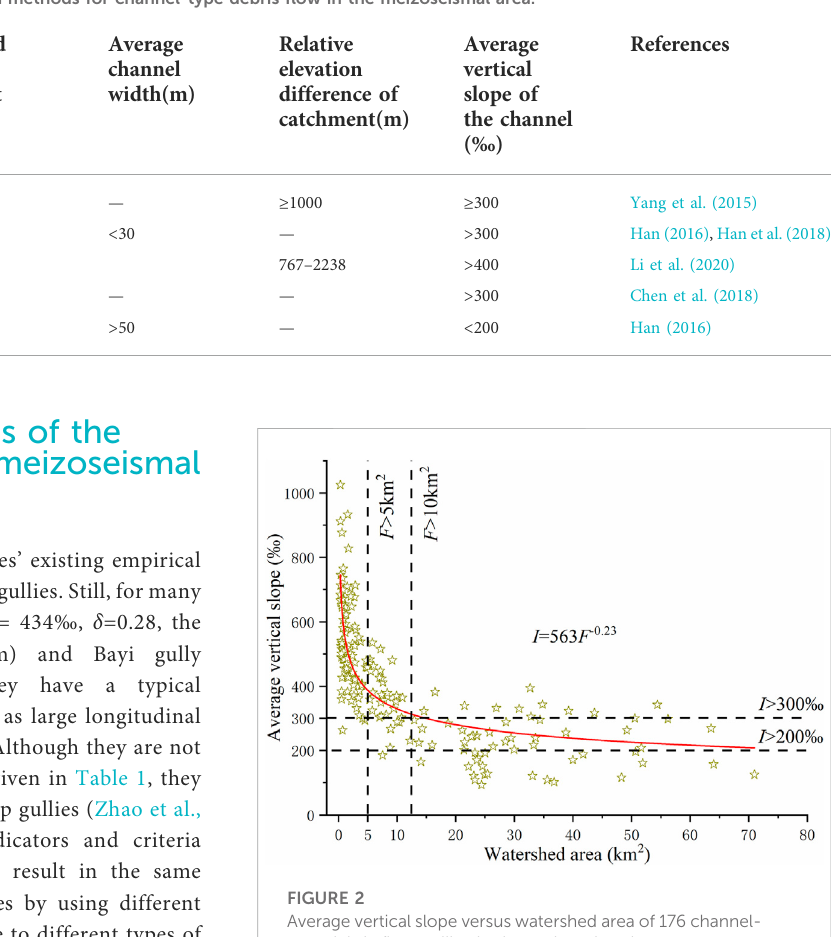
TABLE 1 The existing empirical discrimination methods for channel-type debris fl ow in the meizoseismal area.